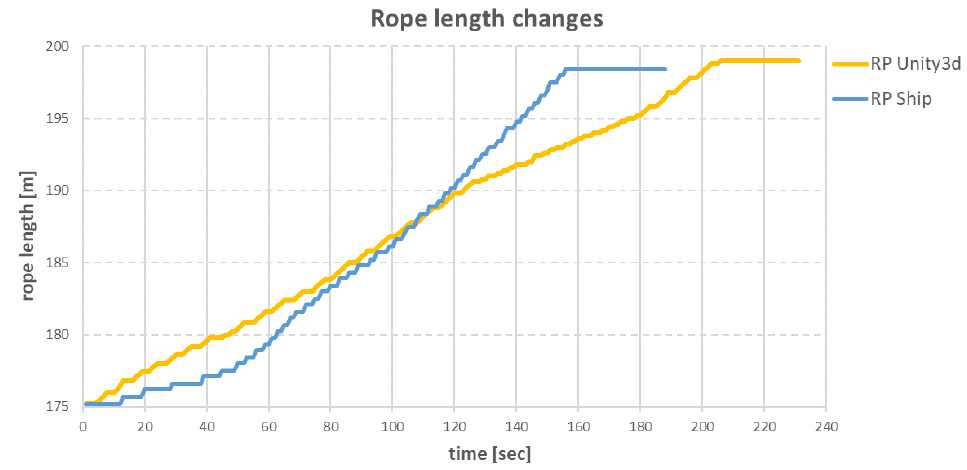
Figure 37. Changes in SS rope lengths over